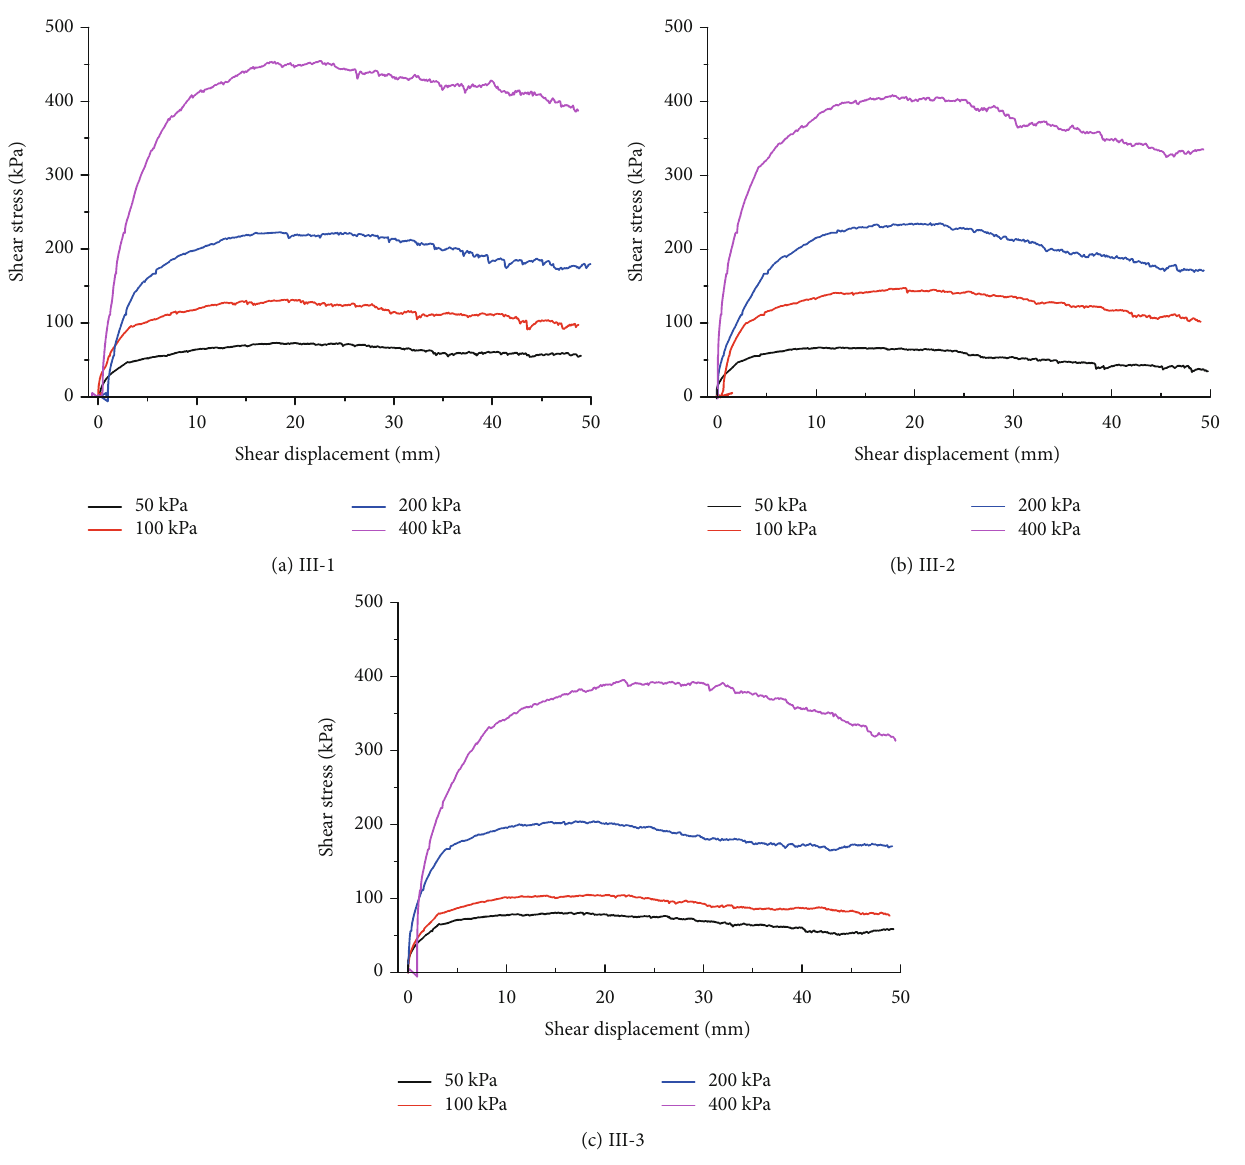
Figure 4: Shear stress versus shear displacement curves of group III (small particle size). Table 3: Shear strength of the